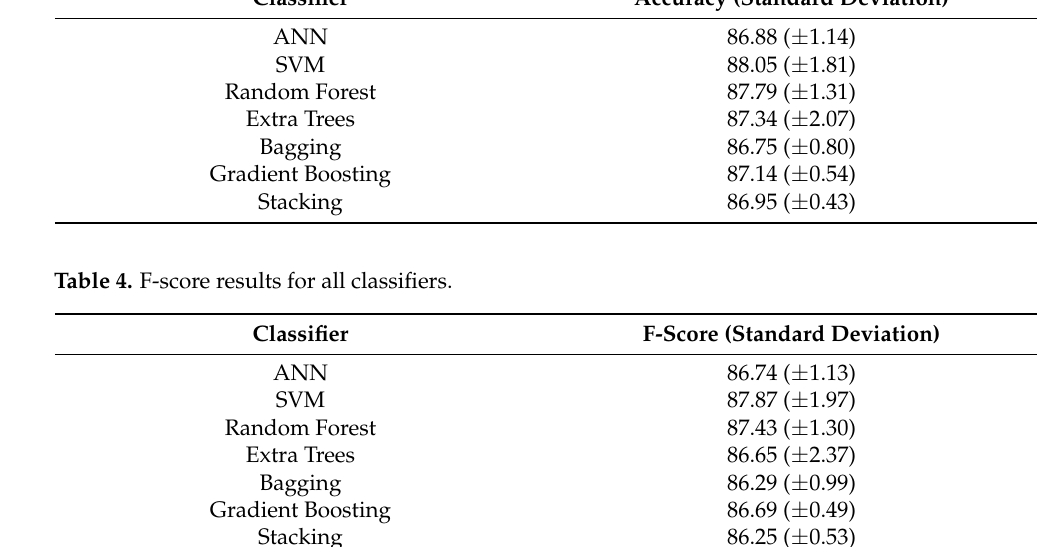
Table 5. AUC results for all classifiers.